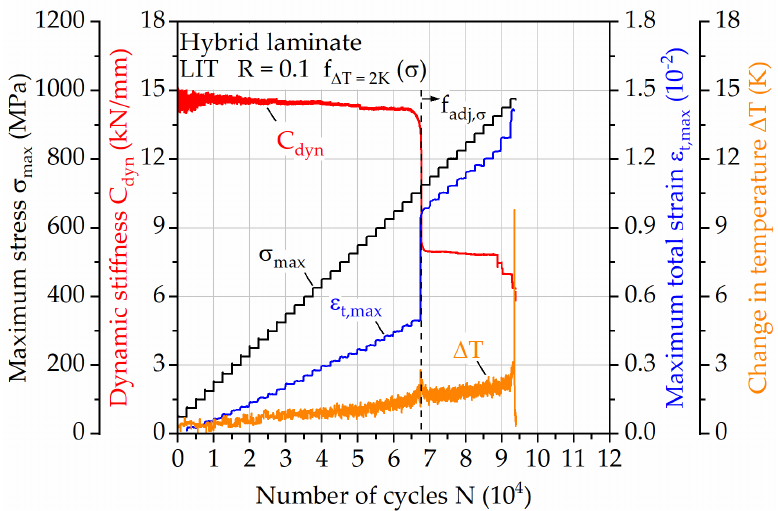
Figure 10. Load increase test for hybrid laminate in 1/2-configuration of 1.4310 and carbon fiber reinforced PA 6, showing the development of dynamic stiffness, change in temperature and maximum total strain for testing with adjusted frequency for a change in temperature of 2 K in combination with further adjustment of the frequency after failure of 1.4310 related to the effective stress.